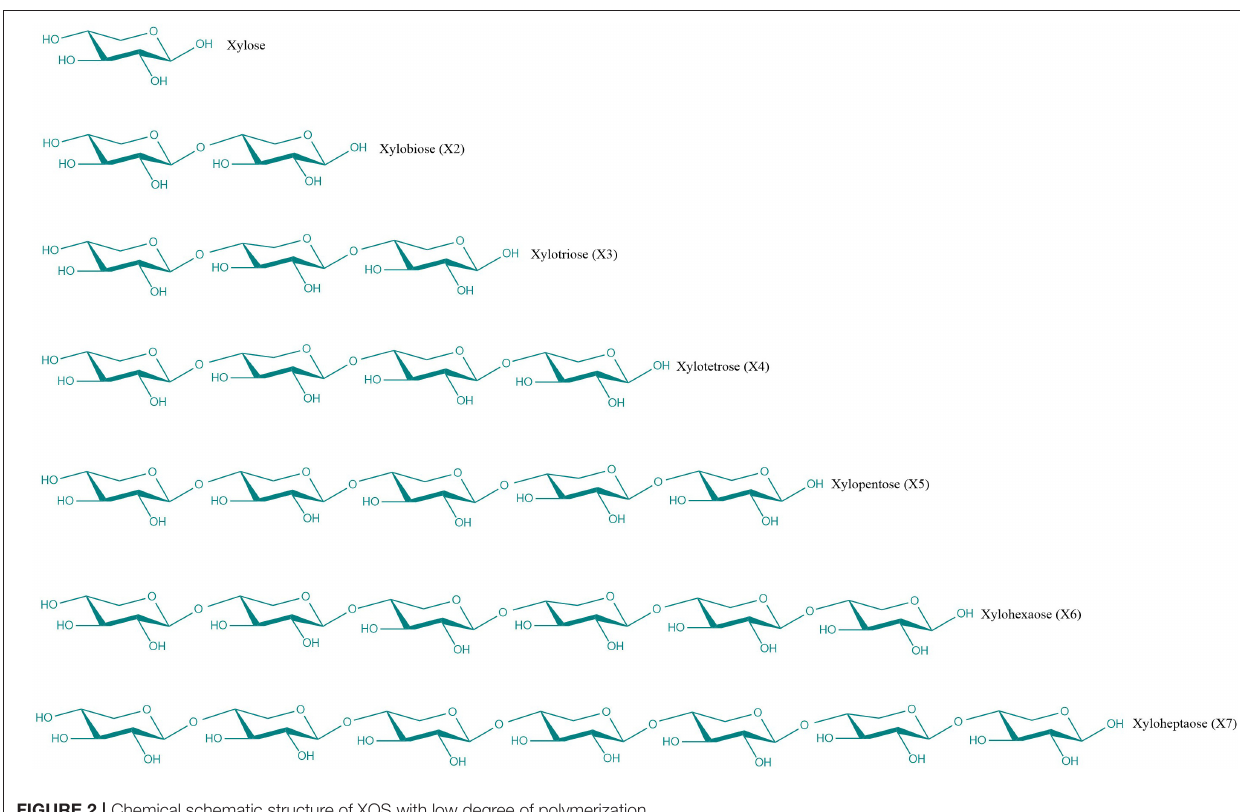
FIGURE 2 | Chemical schematic structure of XOS with low degree of polymerization.